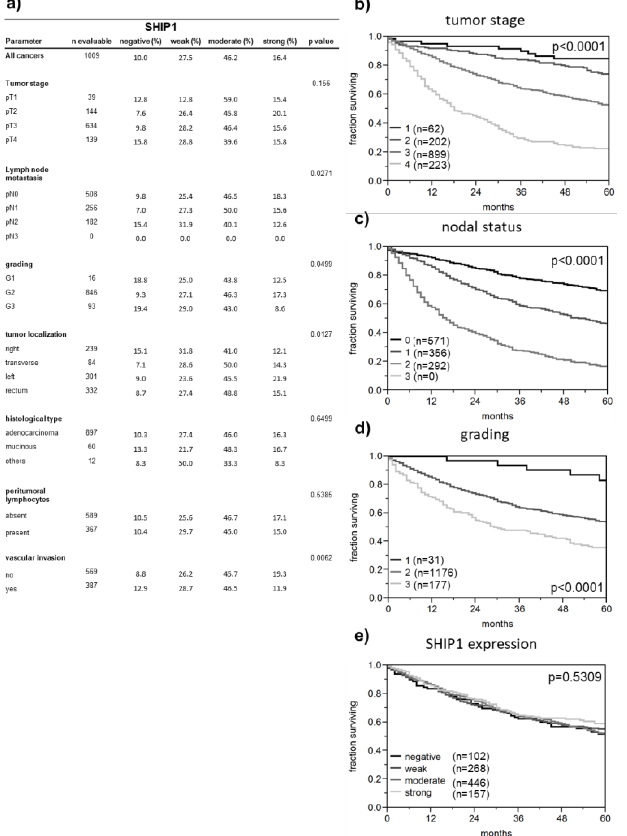
Figure 2. Association of SHIP1 expression with clinicopathological parameters in colorectal cancer. ( a ) Relationship between SHIP1 staining, tumor phenotype and clinical parameters. Patient survival is related to tumor stage ( b ), nodal status ( c ), and tumor grade ( d ), but not to SHIP1 expression ( e